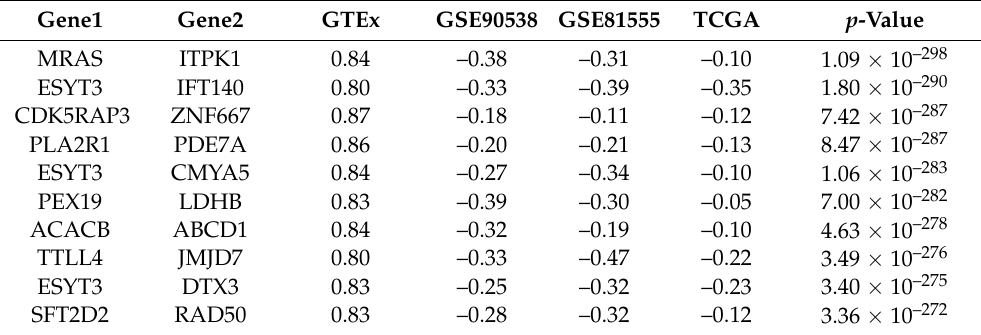
Table 1. Top 10 significant results of DCG analysis. The degree of coexpression is represented with correlation coefficients.